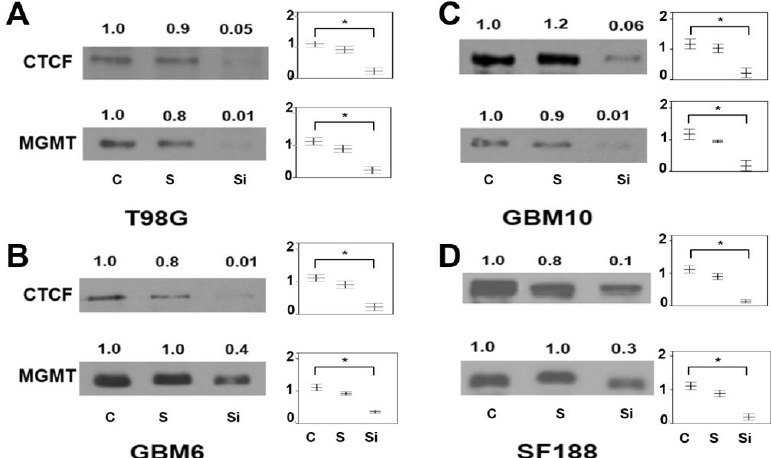
Figure 7. Significant downregulation of MGMT expression after silencing of the CTCF gene using siRNA targeted CTCF transcript variant 1 (NM_006565.3) in 4 glioblastoma cell lines shown in panels ( A – D ). Significant differences as determined by ANOVA are shown with an asterisk (*) from three independent experiments ( p < 001).